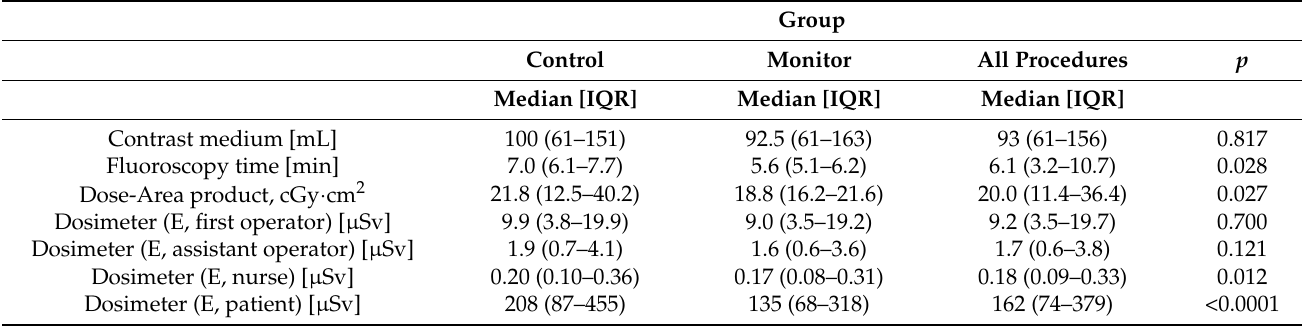
Table 2. The impact of real-time dosimetry monitoring.